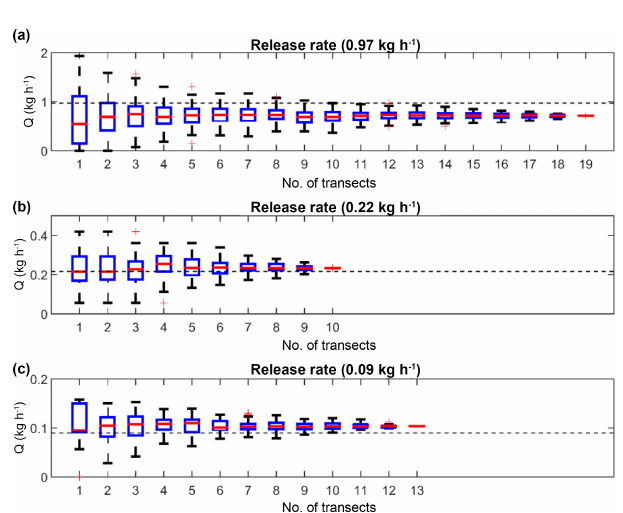
Figure 10. A comparison of the convergence of the mean plume rate inferred from the IGM by averaging randomly selected transects for (a) the 0.97kgh − 1 release rate, (b) the 0.22kgh − 1 release rate and (c) the 0.09kgh − 1 release rate. The actual release rate is shown as a dashed black line. Box and whiskers plots show the 50th percentile (red), 25th and 75th percentile (blue), and minimum and maximum values (black) of the means obtained for each number of transects. Outliers are shown in